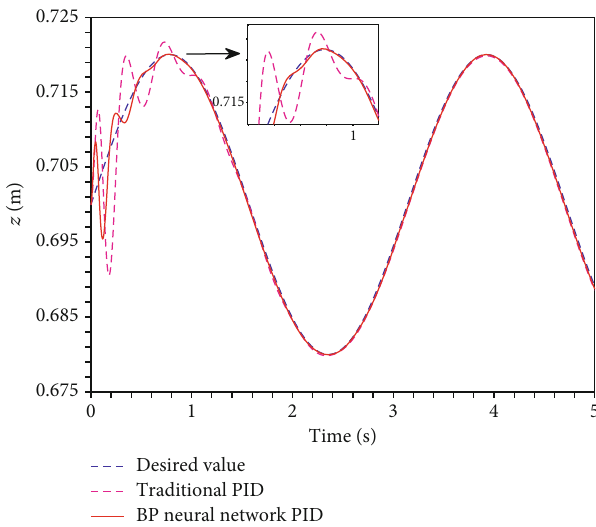
Figure 13: The desired position of the actuated joint d .